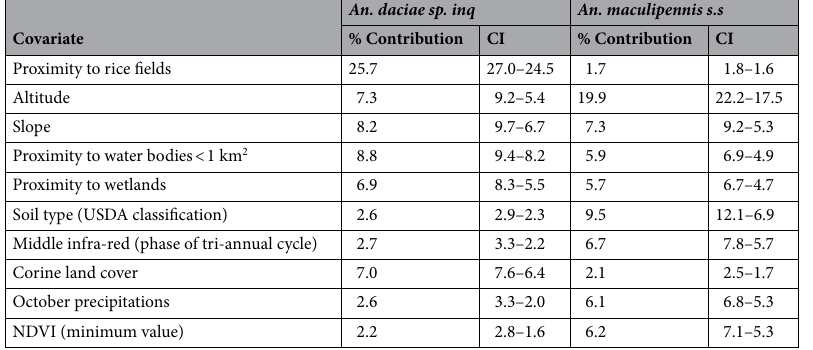
Table 4. Relative contributions to the ENMs of selected covariates, with the related confidence intervals